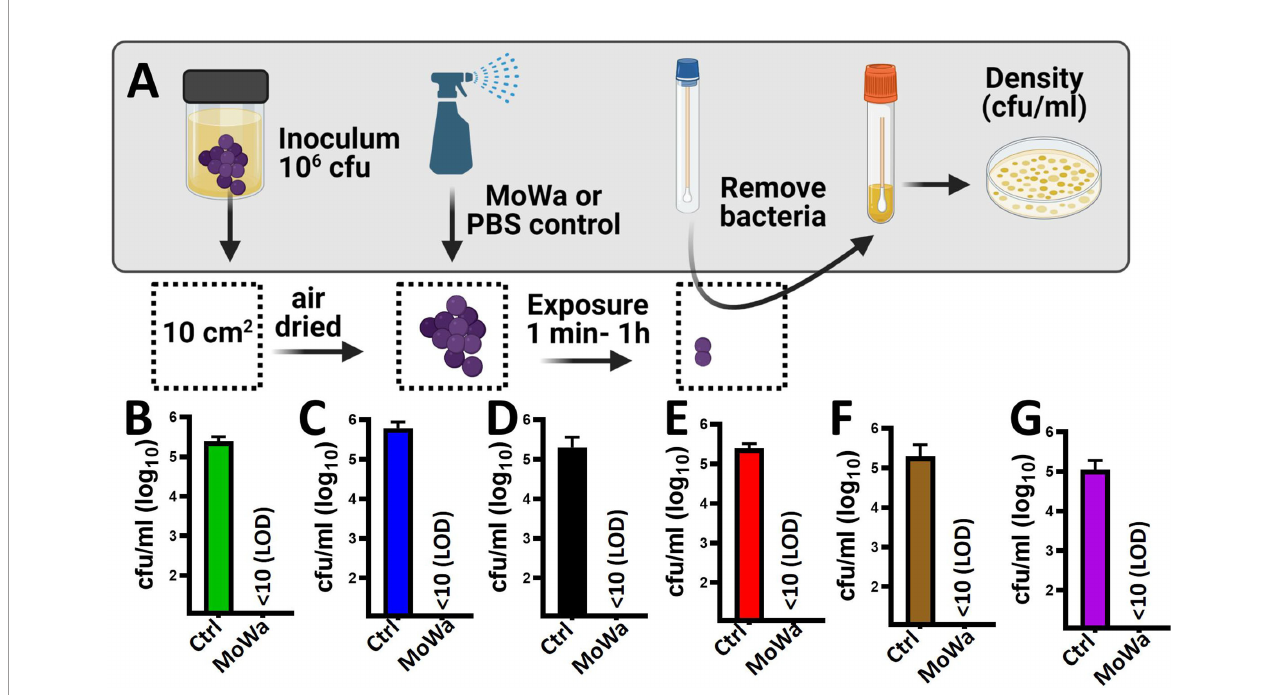
FIGURE 4 | MoWa ef fi ciently decontaminate surfaces containing MRSA and MSSA strains. (A) Sterilized surface of 10 cm2 was spiked with ~10 6 cfu S. aureus strain and air-dried during 1 h. Contaminated surfaces were then sprayed with PBS (control) or with a mixture levulinic acid (LA) and SDS at a concentration of 1/0.04 M (MoWa). Bacteria were removed from MoWa treated, or mock-treated, surfaces 1 min post-treatment and immediately diluted and plated onto BHI agar plates containing 7% of NaCl to obtain colony counts (cfu/ml). Strains tested were (B) NRS384, (C) NRS408, (D) NRS49, (E) NRS236, (F) NRS230 or (G) NRS242. Error bars represent the standard errors of the means calculated using data from at least three independent